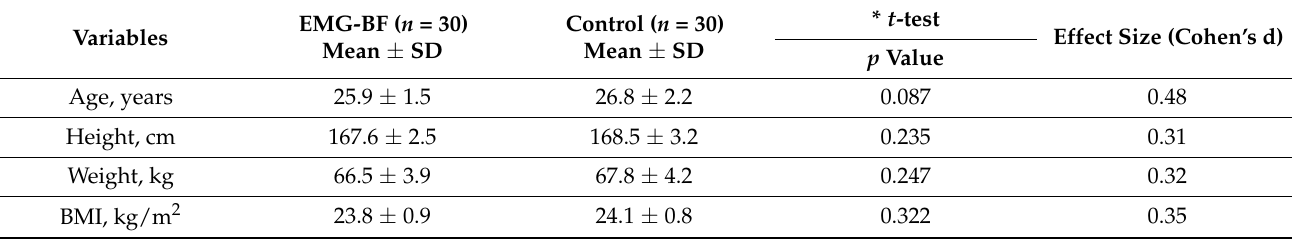
Table 1. Demographic statistics.